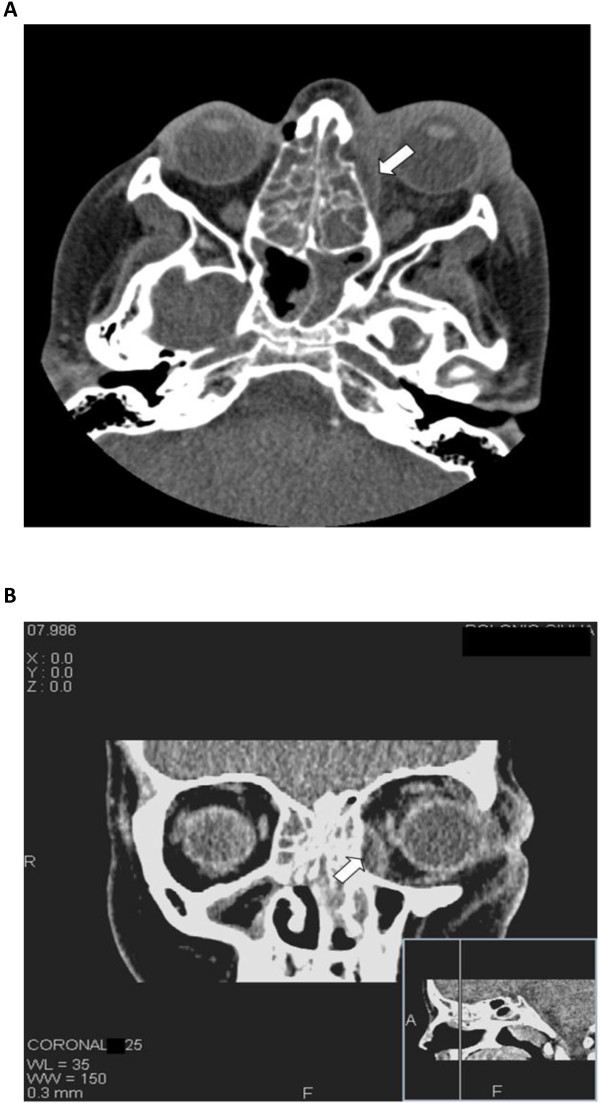
A-B. Axial (A) and coronal (B) CT unenhanced scan through the middle orbit. The images show: increased thickness of skin and soft tissue overlying the medio-lateral area of the left orbit, decreased transparency of the ipsilateral intraconal and extraconal fat tissue and a subperiosteal abscess along the medial wall of the left orbit (white arrows), adjacent to the opacified ethmoid air cells with resultant lateral displacement of the medial rectus muscle (b) A partial obliteration of sphenoid (A) and maxillary sinuses (B) is also visualized.